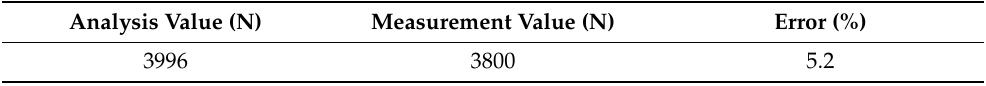
Table 3. Analysis value and measurement value